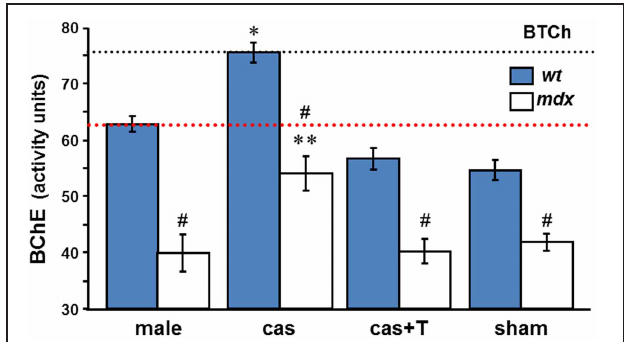
FIGURE 4 | T-regulation of BChE activity in male mdx sera. BChE activities were measured colorimetrically with BTCh as substrate in sera of intact, castrated, castrated with T-replacement, and sham operated wt (cid:2) and mdx (cid:3) mice, (as in Figure 3A ). Values, mean ± SEM for samples taken from 4 to 8 mice per group (sham group, n = 3). ∗ p < 0 . 001 between BChE levels in castrated wt and in intact, T-treated, and sham mice sera (of either wt or mdx strains). ∗∗ p < 0 . 05 (detailed in Table 3 ) between BChE levels in castrated mdx and in intact, T-treated, and sham mdx mice sera. #Significant difference between BChE level in mdx and wt in all the experimental groups ( p -values are listed in Table 2 ). The dashed black and red lines indicate BChE levels in agonadal and gonadal wt sera, respectively.